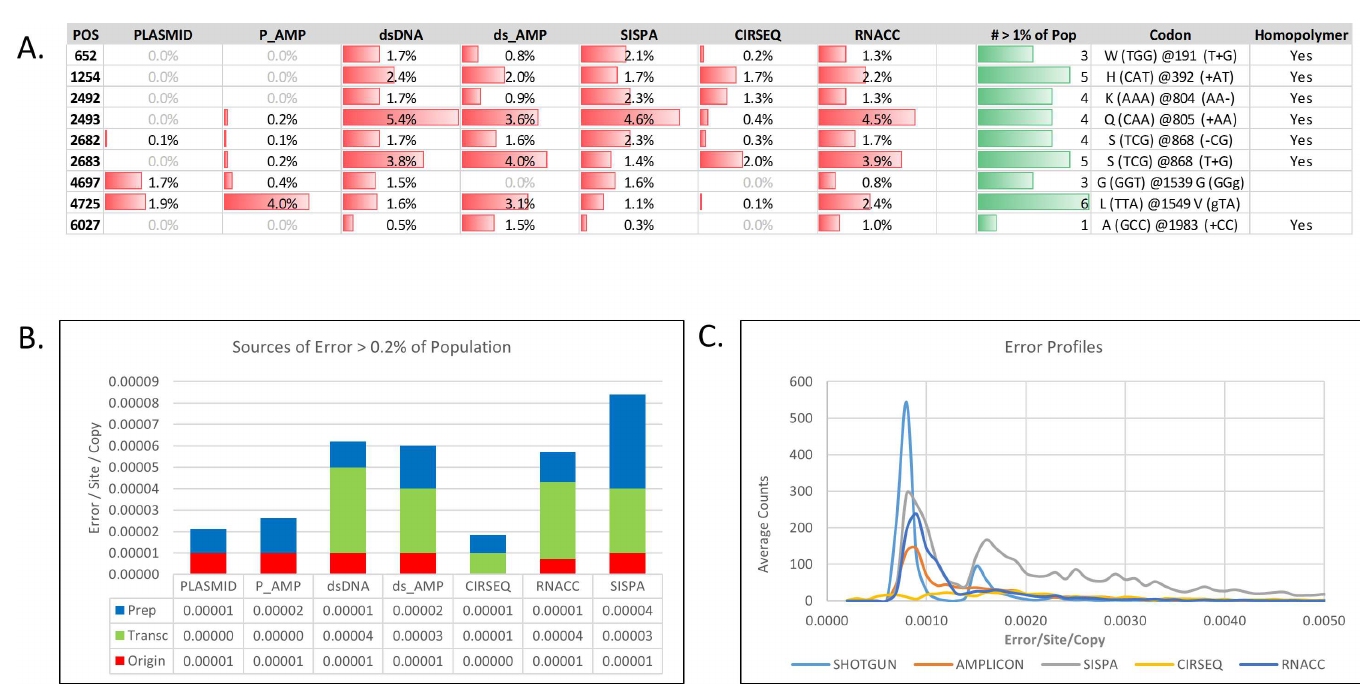
Fig 4. Sources of error per sample preparation method. (A) Intra-host single nucleotide variants (iSNVs) that were present in multiplesamples at greater than 1% of populationare shown in a heat map format to visualizepatterned diversity acquiredduringsample preparation. The total numberof samples containing iSNVs in greater than 1% of populationare summarized in the column “# > 1% of Pop” in green. “Codon”column (secondcolumn from right) providesboth the nucleotide and protein translationof the site. (B) The detected mean error rates of iSNVs greater than 0. 2% of population(error/site/copy) are stratified by presencein the plasmid(Origin), detectionafter transcription/reversetranscription (Transc) or preparation, and preparation/sequencer error (Prep). (C) Error profiles are expressedas the number of iSNVs per percent of populationobtainedfrom each of the 5 sample preparation methods.